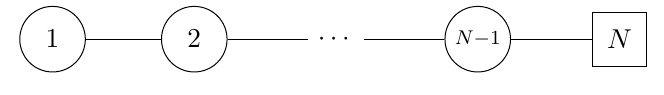
Figure 19 . The T [SU( N )] ascending